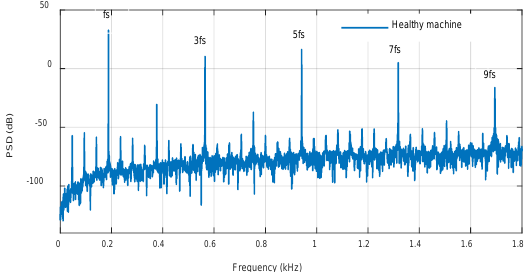
Figure 22. PMSM current spectra normalized plot under a normal case.